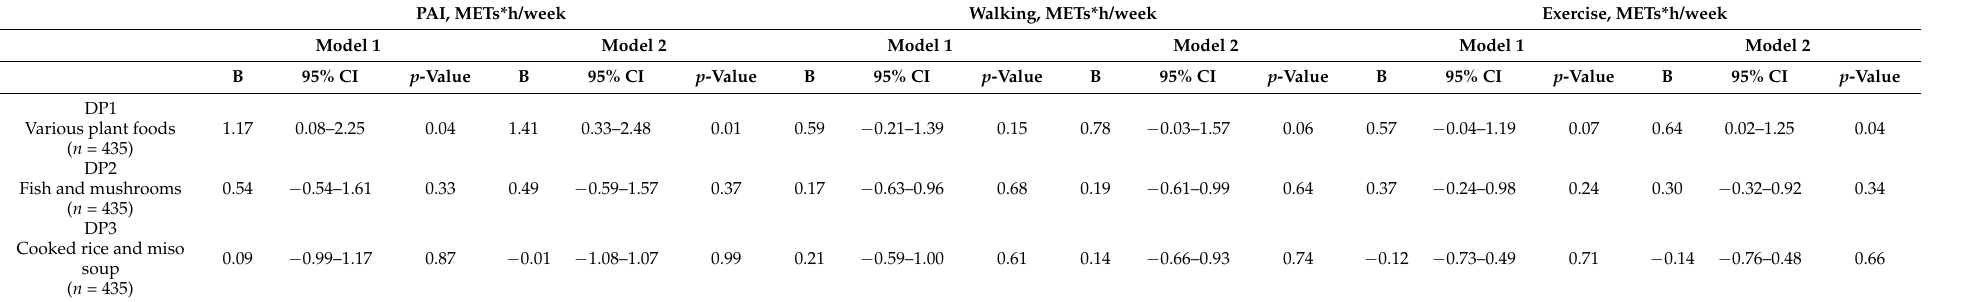
Table 3. The relationship between dietary patterns and subjectively measured physical